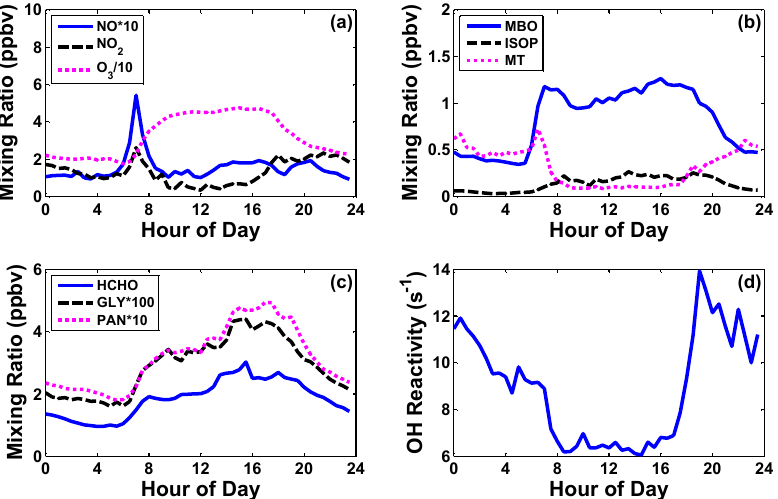
Fig. 2. Average diel observations of (a) NO, NO 2 and ozone, (b) MBO, isoprene and total monoterpenes, (c) formaldehyde, glyoxal and PAN, and (d) OH reactivity. All data are 30min means. Note that some species have been scaled to fit on a single axis, as denoted in the plot